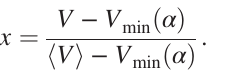
packing fraction. The bold vertical bars indicate the densest local structures for each N (see Fig. 2). The vertical dashed line marks the densest known crystalline packing ϕ triangular tics on the axes mark the global packing fraction and mean Voronoi neighbor count of the dense disordered packings. Bottom row: Marginal distributions of the above for different N . Top right plot: Radial distribution of the supracrystalline clusters, ϕ > ϕ l cry